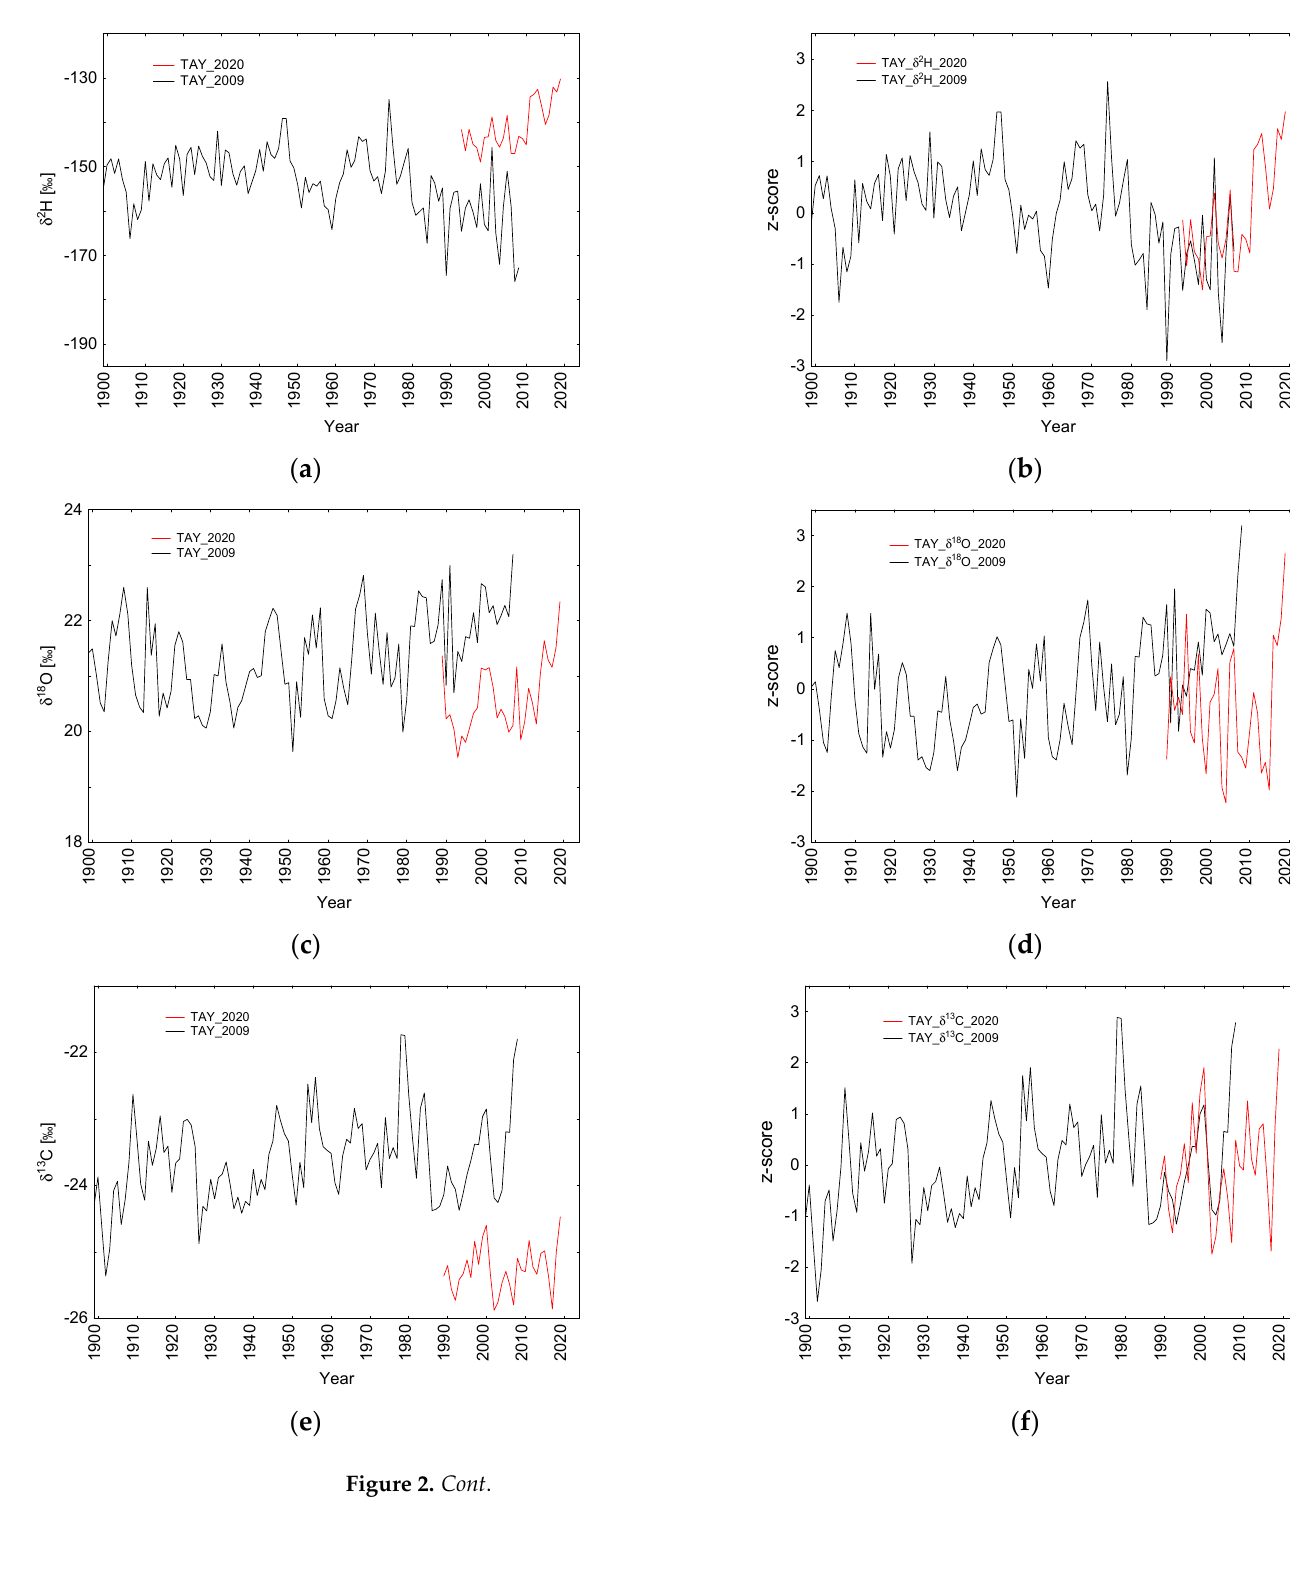
(Figure 2, red lines). Newly obtained δ 2 H chronologies for both study sites from 1990 to 2020 for TAY and 1990 to 2021 for YAK were obtained (Figure 2a,g in red) and merged relative to zero (z-score) with earlier obtained chronologies from the same regions [24] for TAY and [20,25] for YAK (Figure 2b,h, black line), accordingly.